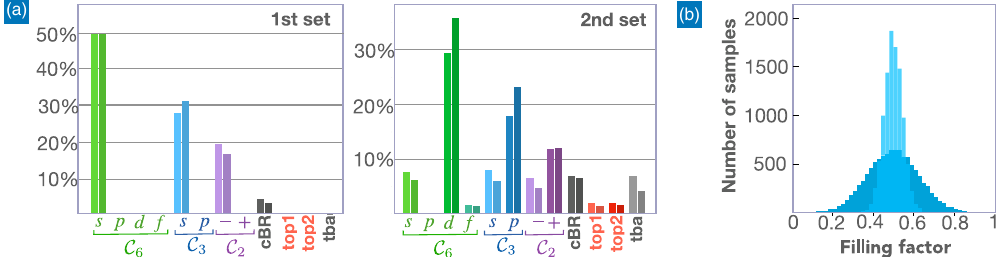
FIG. 11. (a) Comparison of the (quasi-) BR distributions for two different distributions of potentials. The probability bars for a given (quasi-) BR but different distributions are shown side by side. (b) Number of samples as a function of the filling factor [portion of the unit cell where V ð x Þ ¼ V ] for the two distributions of interest. In all panels, the results referring to the training distribution are plotted max in slightly darker